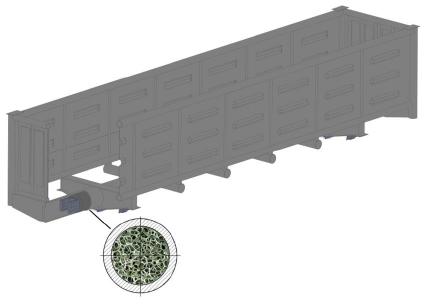
Figure 1. Carrying structure of the circular tube open wagon with aluminum foam as filler for center sill.